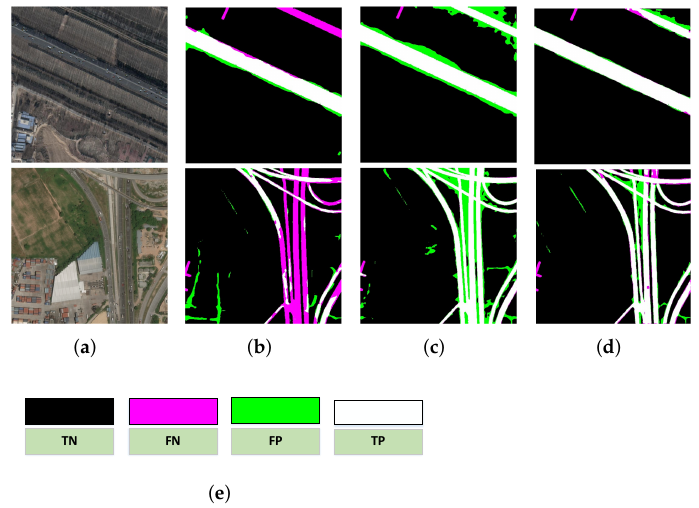
Figure 6. Some qualitative results on Dataset 2. ( a ) The original satellite images; ( b ) The results of D-linknet; ( c ) The results of MD-ResUnet; ( d ) The results of ours. ( e ) legend.